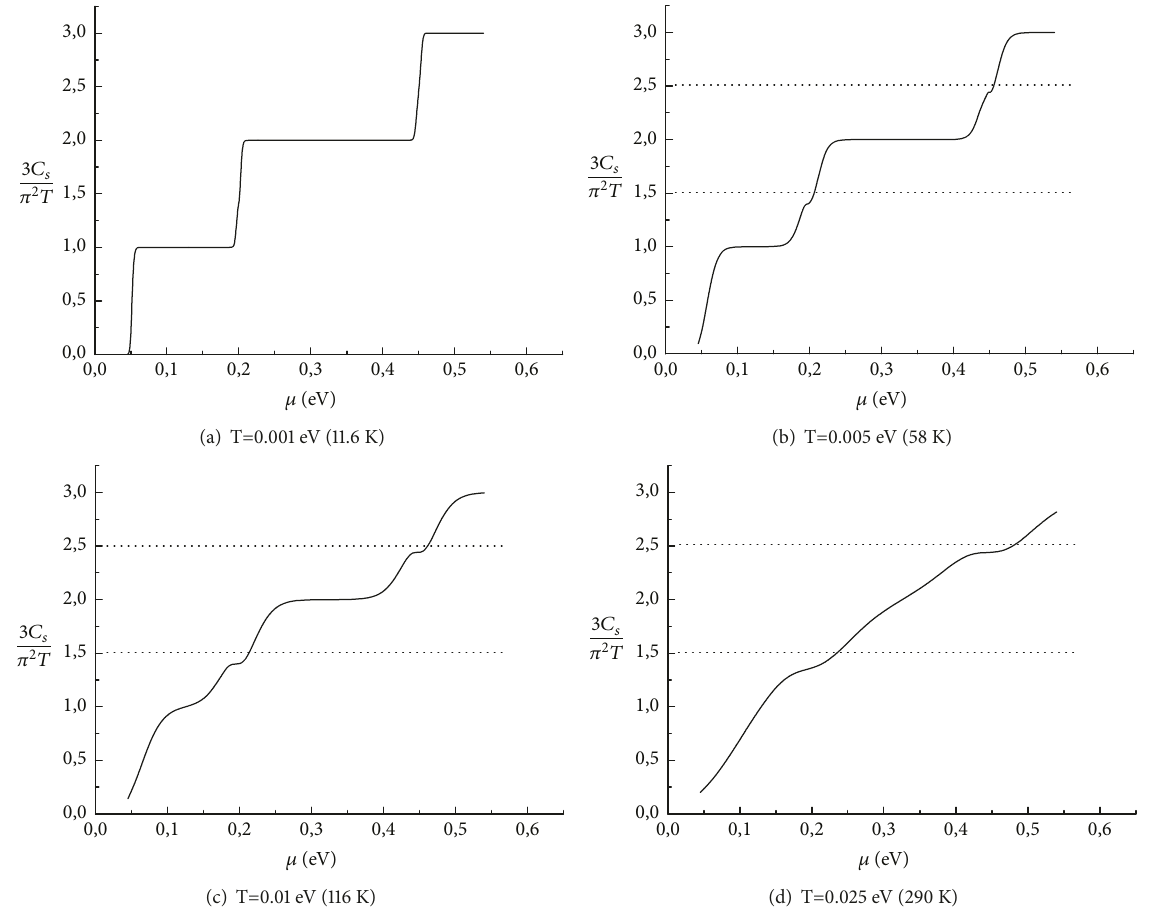
Figure 2: Dependences of the heat capacity of a quasi-two-dimensional electron gas on the chemical potential at 𝐸 1 = 0.05 eV and different temperatures: (a) T = 0.001 eV (11.6 K), (b) T = 0.005 eV (58 K), (c) T = 0.01 eV (116 K), and (d) T = 0.025 eV (290 K).